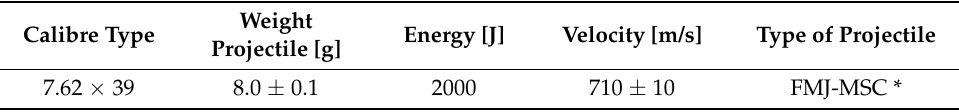
Table 3. Technical parameters and characteristics of the ammunition used.